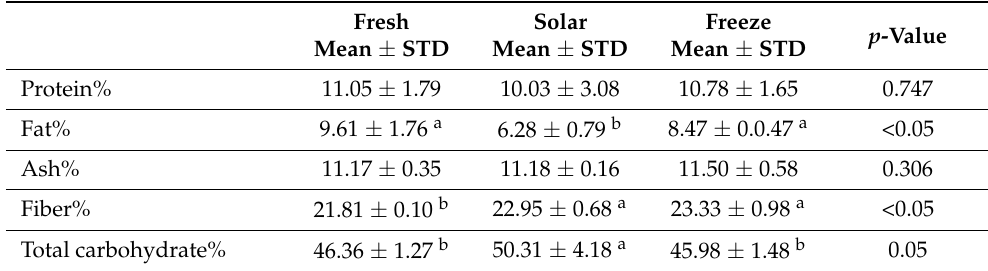
Total carbohydrate% Different superscript letters in a row are significantly different ( p ≤